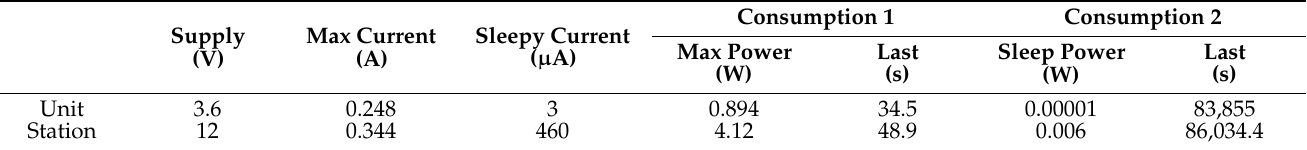
Table 1. Detailed system power consumption (one day, one